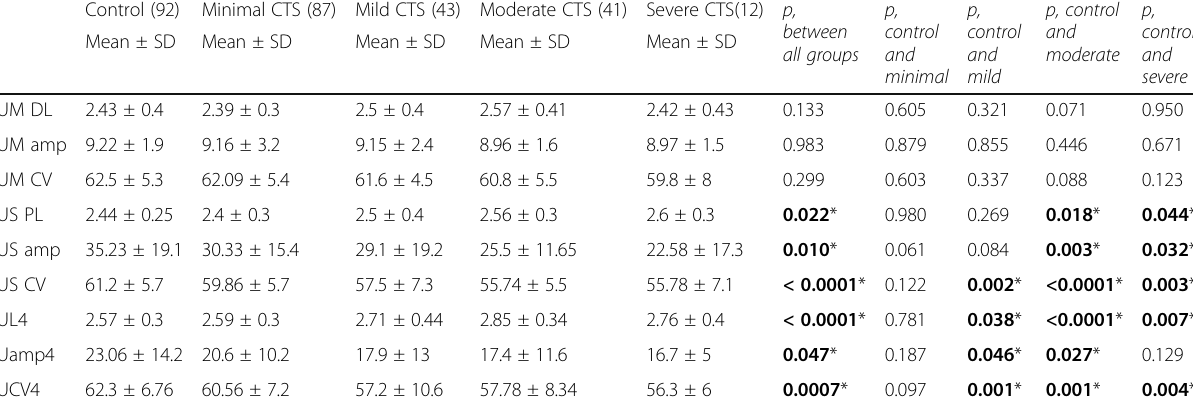
Table 3 Comparison of different ulnar nerve conduction study parameters between patients with different CTS electrophysiological severity grades and control subjects